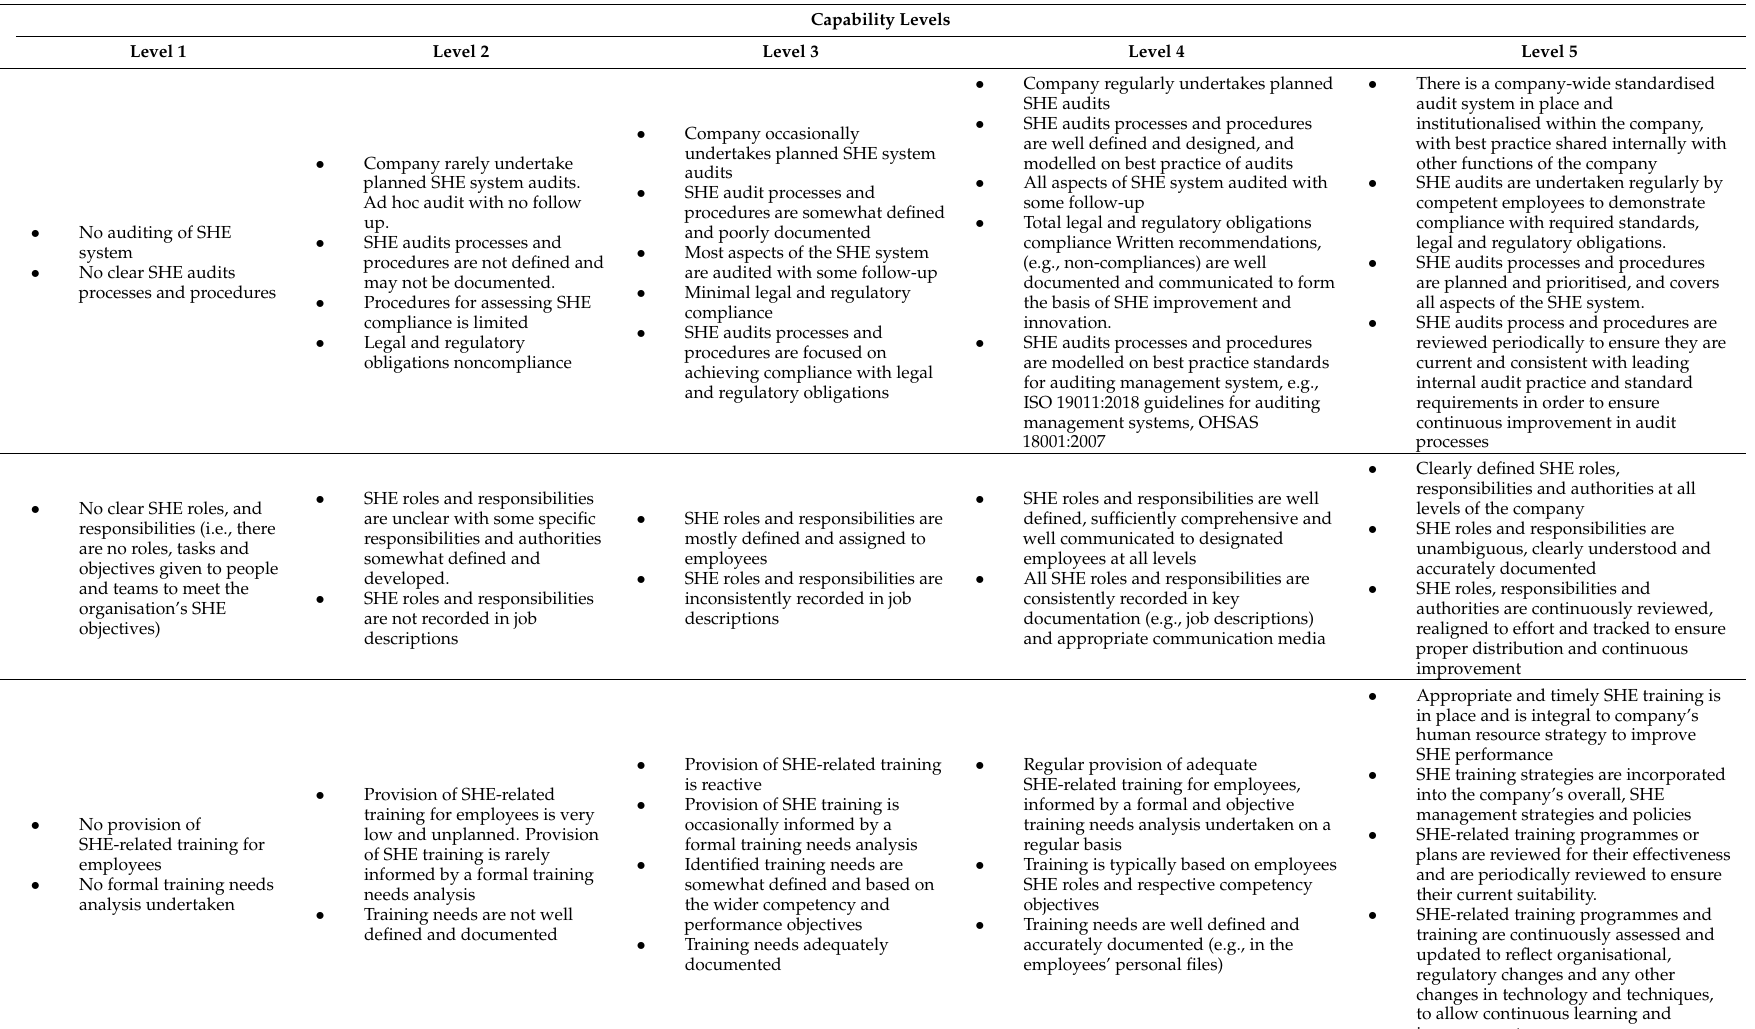
Table A1. Cont. Integrated Safety, Health and Environmental Management Capability Maturity Model